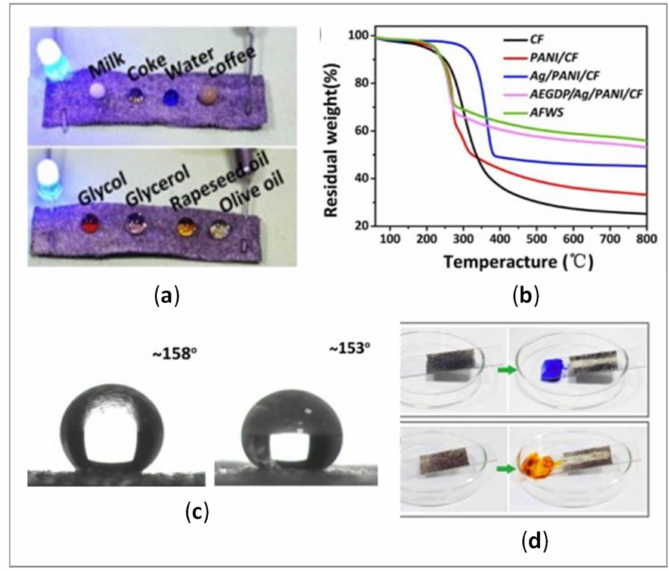
Figure 8. ( a ) Demonstration of Ag/PANI conductive fabric for use in circuits supplying power to LEDs, and corresponding ( b ) TGA results, ( c ) WCA and Oil Contact Angle (OCA) on the surface of samples, and ( d ) The self-cleaning property of the surfaces contaminated with methyl blue and methyl red powders. (Reprinted with permission from Ref. [117] Copyright 2022